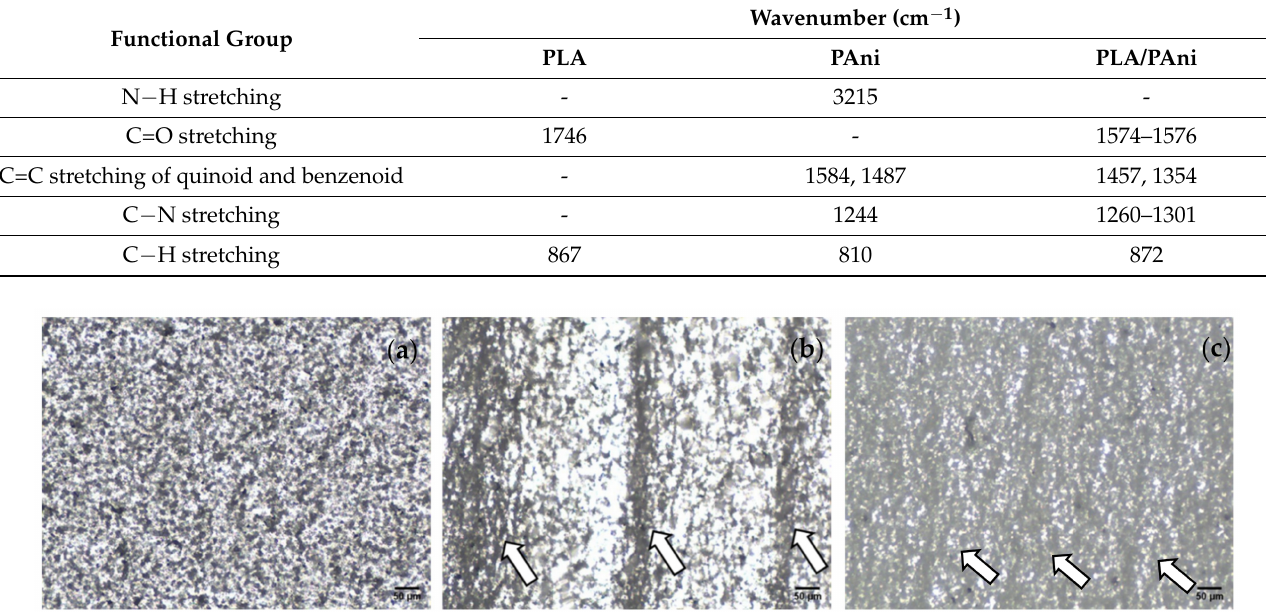
Figure 3. Microscope image of ( a ) non-crazed PLA/PAni film, ( b ) crazed PLA/PAni film, ( c ) crazed PLA/PAni film after the annealing